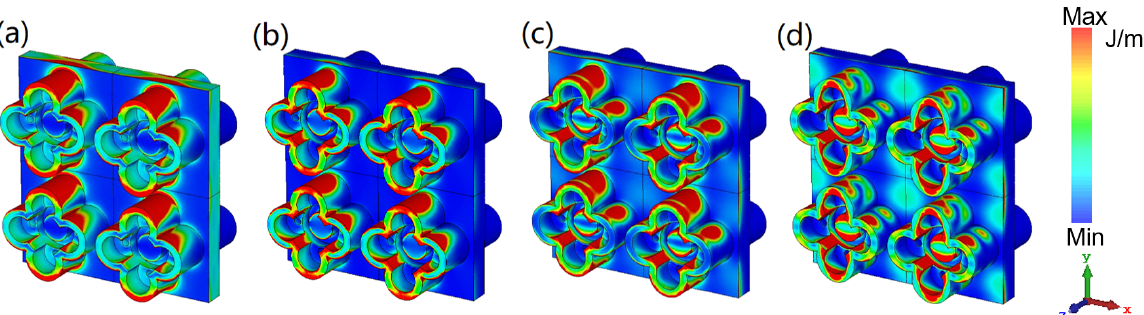
Figure 6. The electric field energy density of water layer at ( a ) 6.86 GHz; ( b ) 16.34 GHz; ( c ) 24.72 GHz; ( d ) 40 GHz.